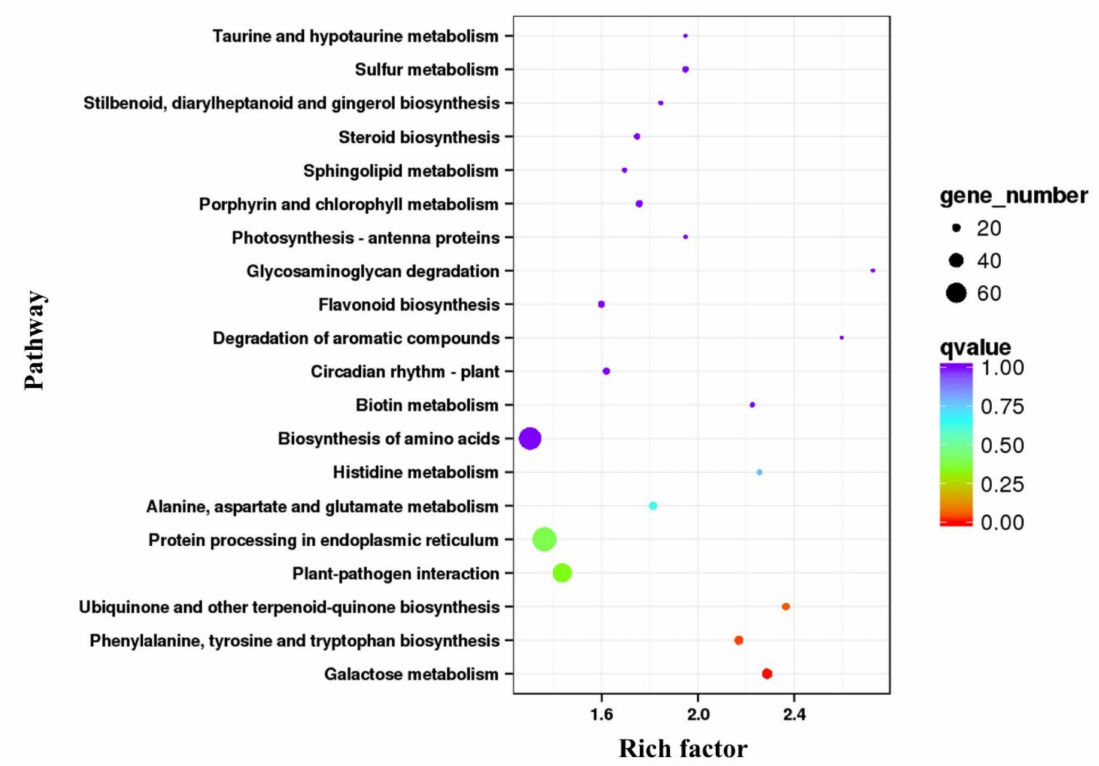
Figure 4. KEGG pathway enrichment analysis in sand pear flesh of two cultivars at 1 h. Rich factor refers to the ratio of the DEGs number annotated in this pathway and the number in all genes; large rich factor indicates significant enrichment. The color of the circle represents the value, which is an adjusted p -value by multiple hypothesis